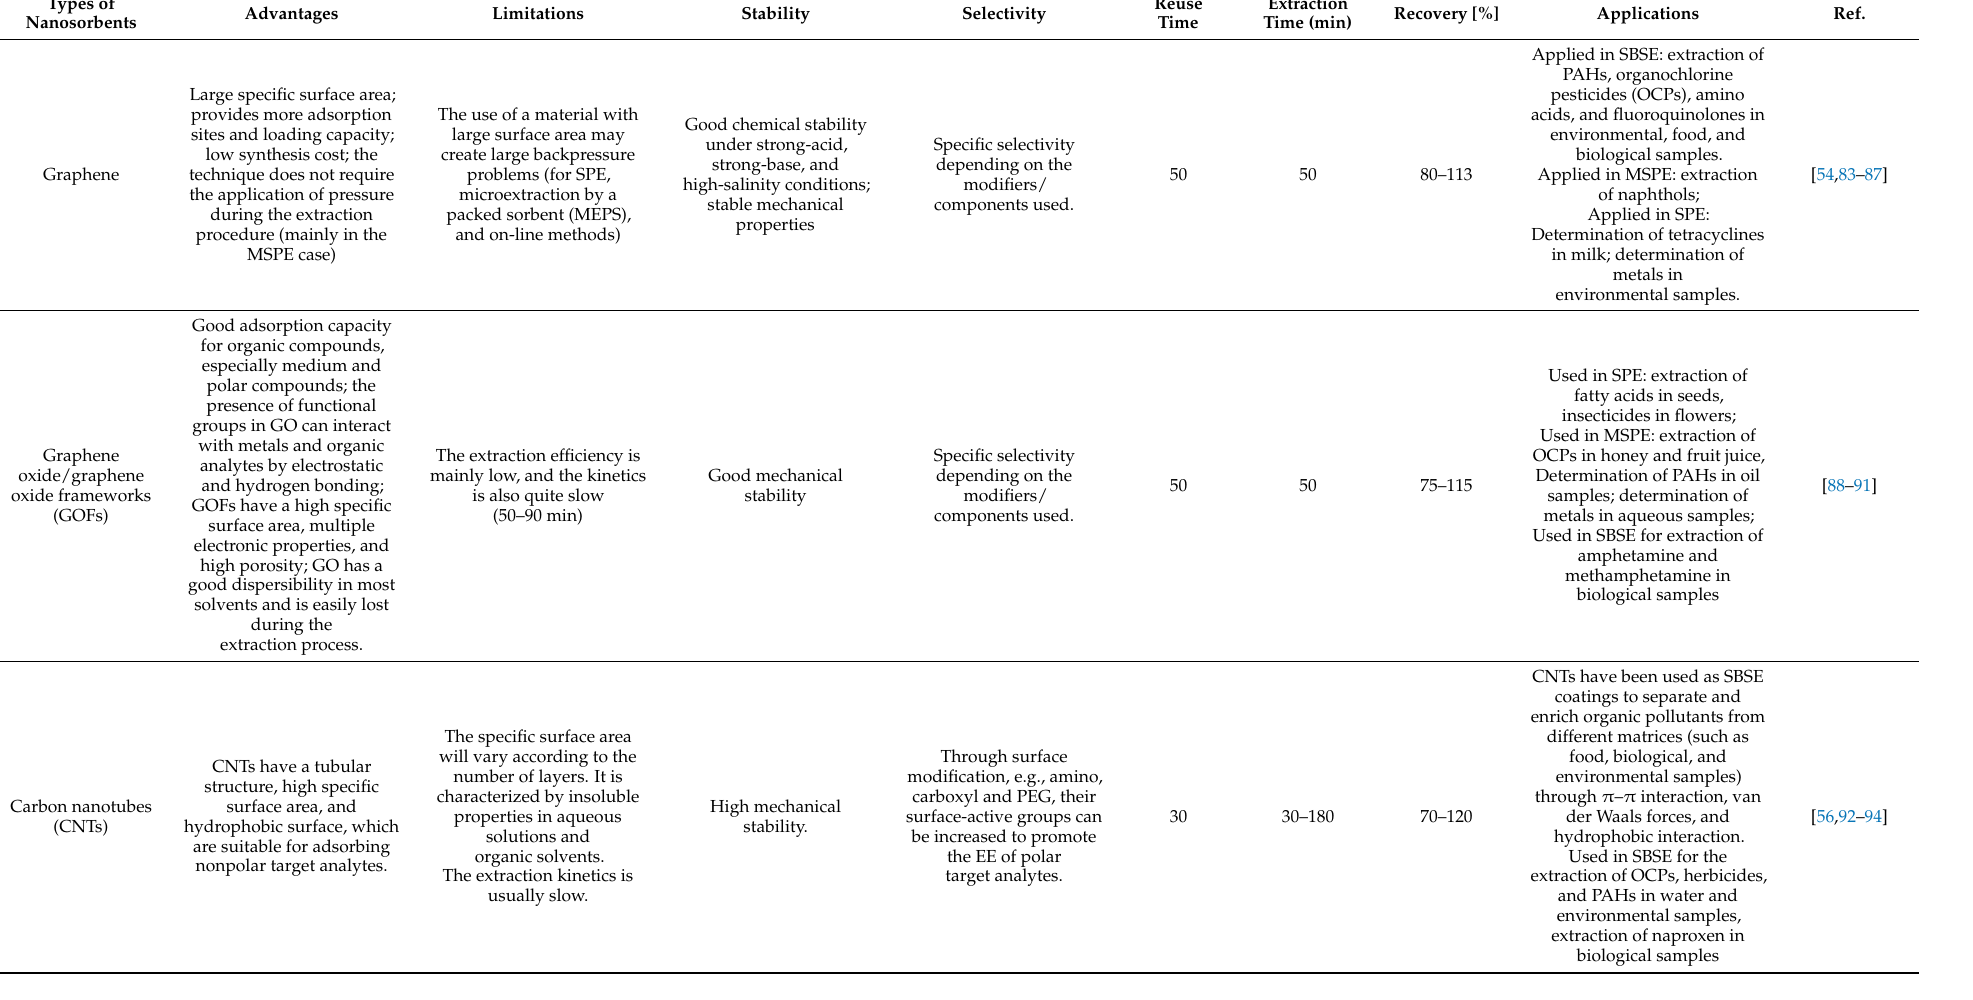
Table 8. Comparison and characteristics of specific NPs used as a sorbent in extraction